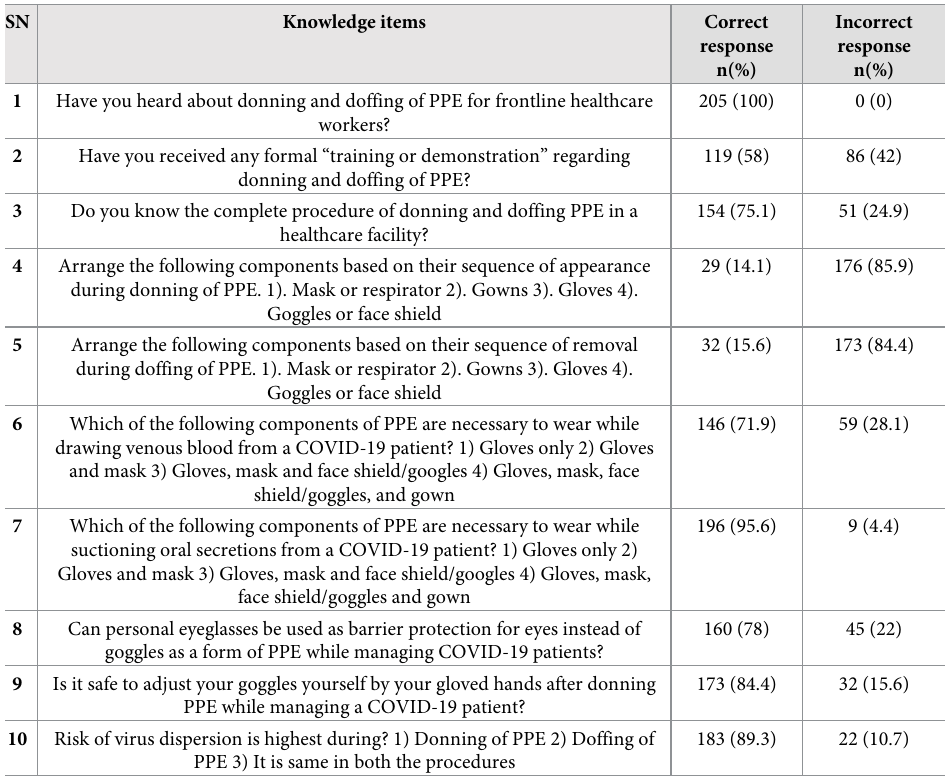
Table 3. Knowledge per individual components regarding donning and doffing (n =